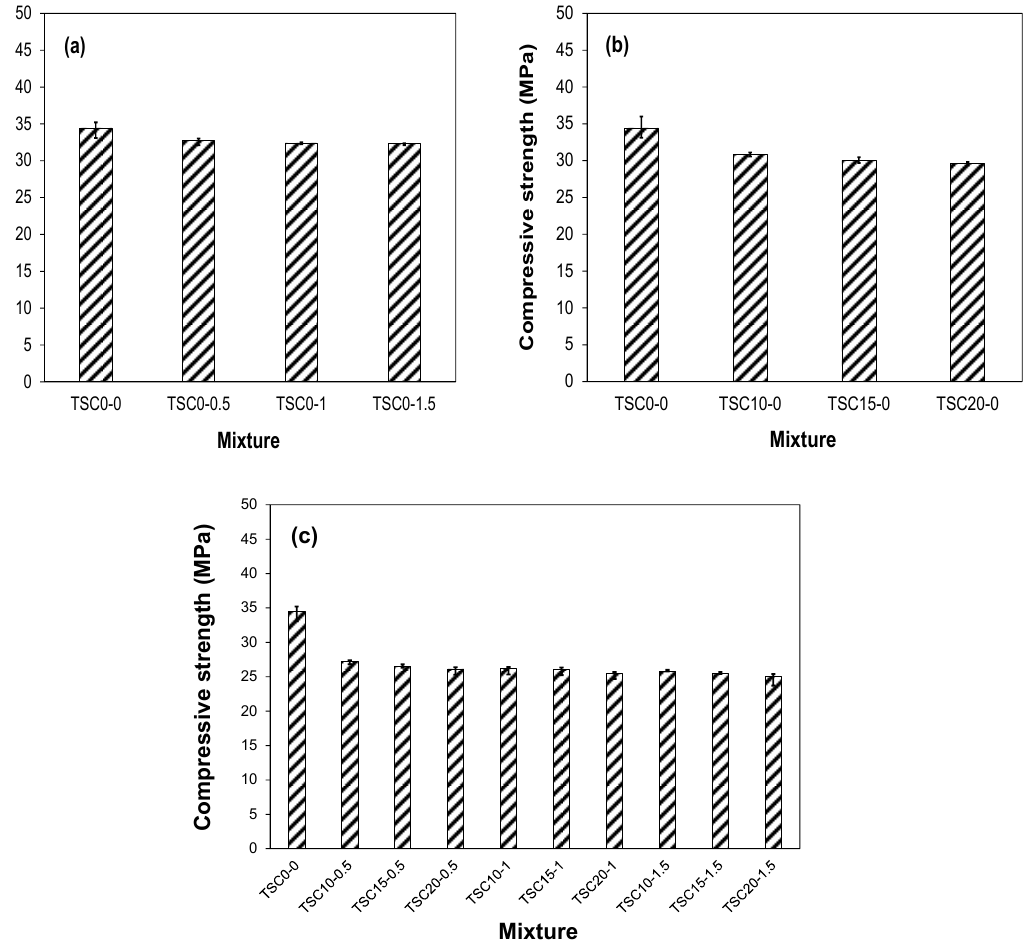
Figure 5. Compressive strength of different TSC specimens: ( a ) steel wires, ( b ) tire rubber, and ( c ) steel wire and tire rubber.